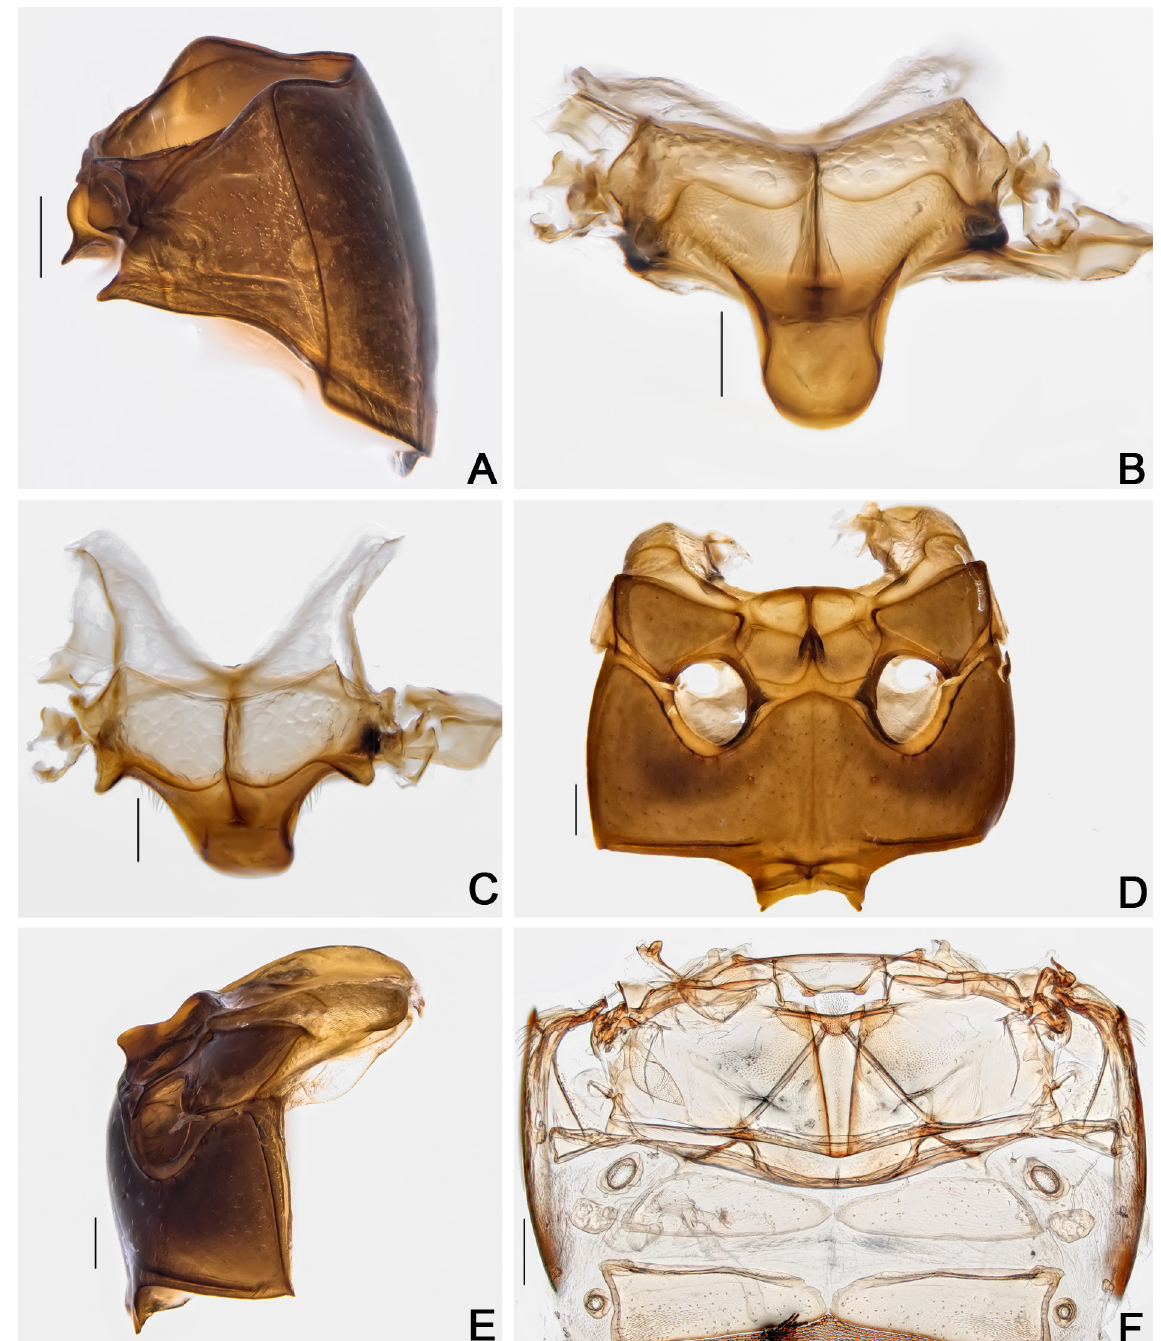
Fig. 50. Cyparium collare Pic, 1920, ♂ (CELC). A . Prothorax, lateral view. B–C . Scutellar plate. B . Dorsal view. C . Apically slanted view. D–E . Meso- and metathorax. D . Ventral view. E . Lateral view. F . Metanotum. Specimen collected at Mata do Paraíso, Viçosa (MG, Brazil). Scale bars: A, D–F = 0.2 mm; B–C = 0.1